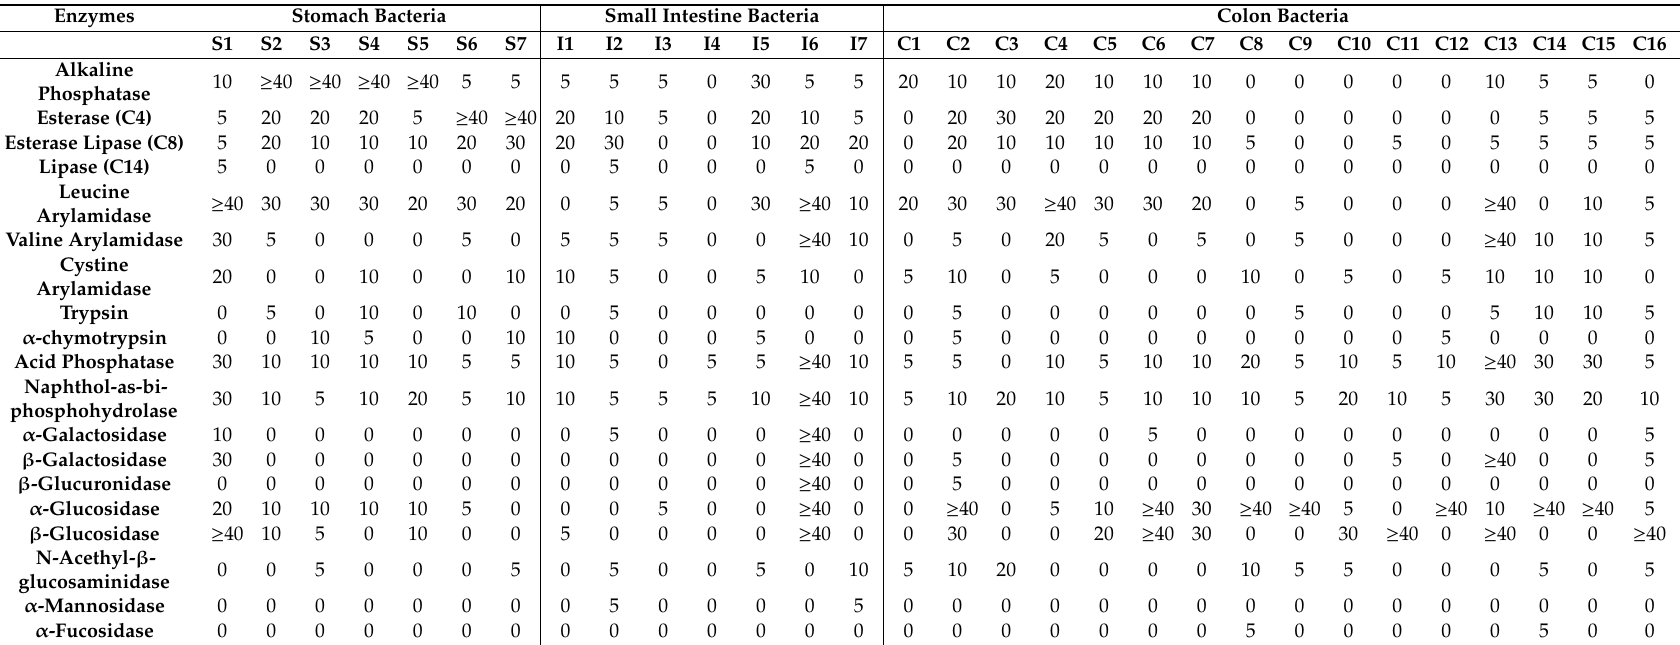
Table 1. Results of the enzymatic activity of the isolated bacteria (in